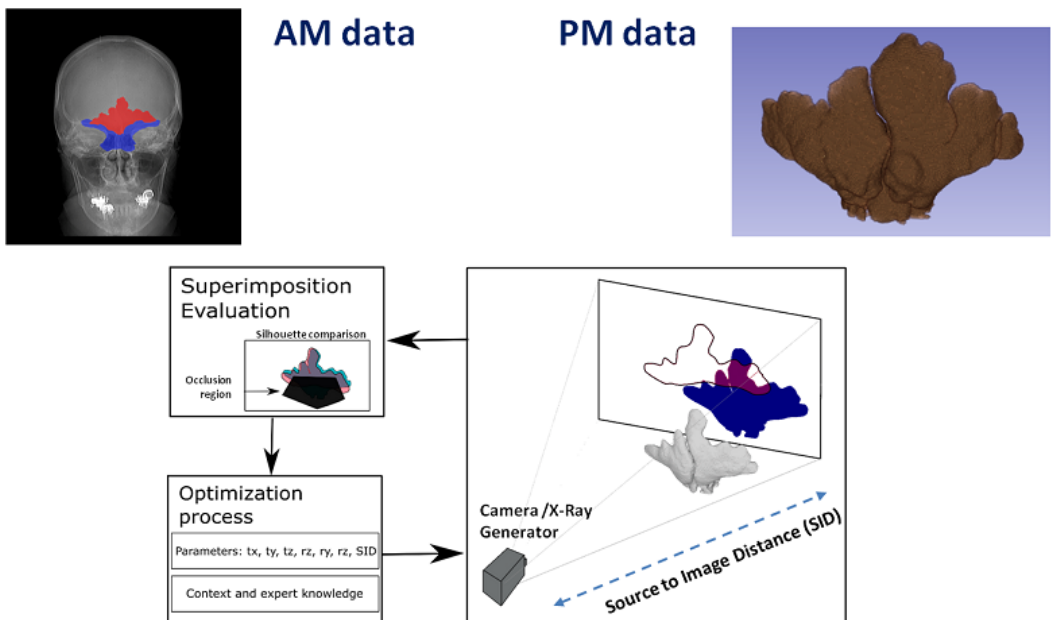
Figure 5. Schematic representation of the automatic comparison of anatomical structures in radiographic materials. This figure uses the frontal sinuses as an example. Once AM (X-Ray) and PM (CT) data are segmented (either automatically or manually), both are superimposed using an evolutionary image registration algorithm. Three main interconnected blocks are represented: (i) The transformation to obtain a projection of the 3D model; in this example, the geometric transformation includes translation (tx, ty, and tz), rotation (rx, ry, and rz), and source to image distance (SID). (ii) The similarity metric that compares the PM projection and the AM segmentation considering an occlusion region (i.e., where the frontal sinuses are occluded or not clearly defined). (iii) The optimization process to estimate the nine parameters of the transformation that are only limited by the context and expert knowledge from the X-ray acquisition protocol.